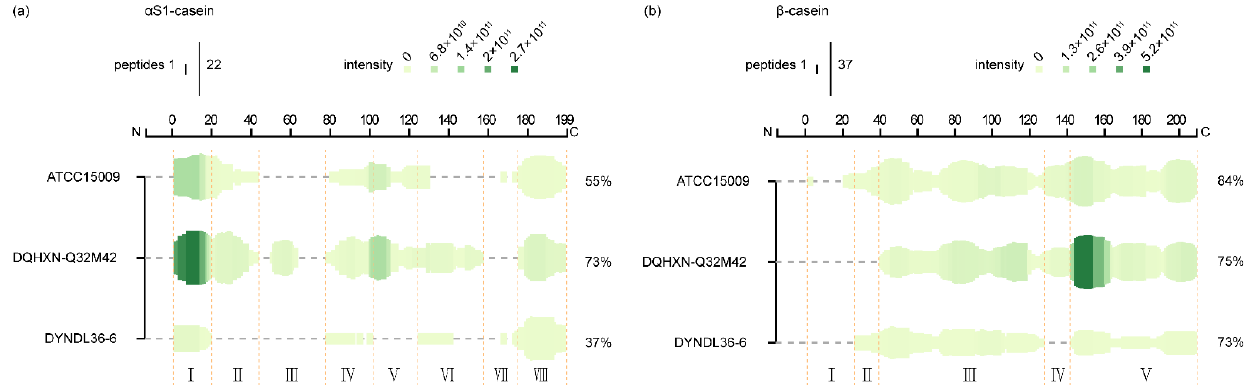
Figure 3. Heat map of ( a ) α S1-casein and ( b ) β -casein. The height of the green bars and the intensity of the green color are proportional to the count of peptides and the sum of the peptide peak intensities overlapping this position, respectively. The count of peptides overlapping a residue and the sum of their intensities is displayed at the top of the figure.